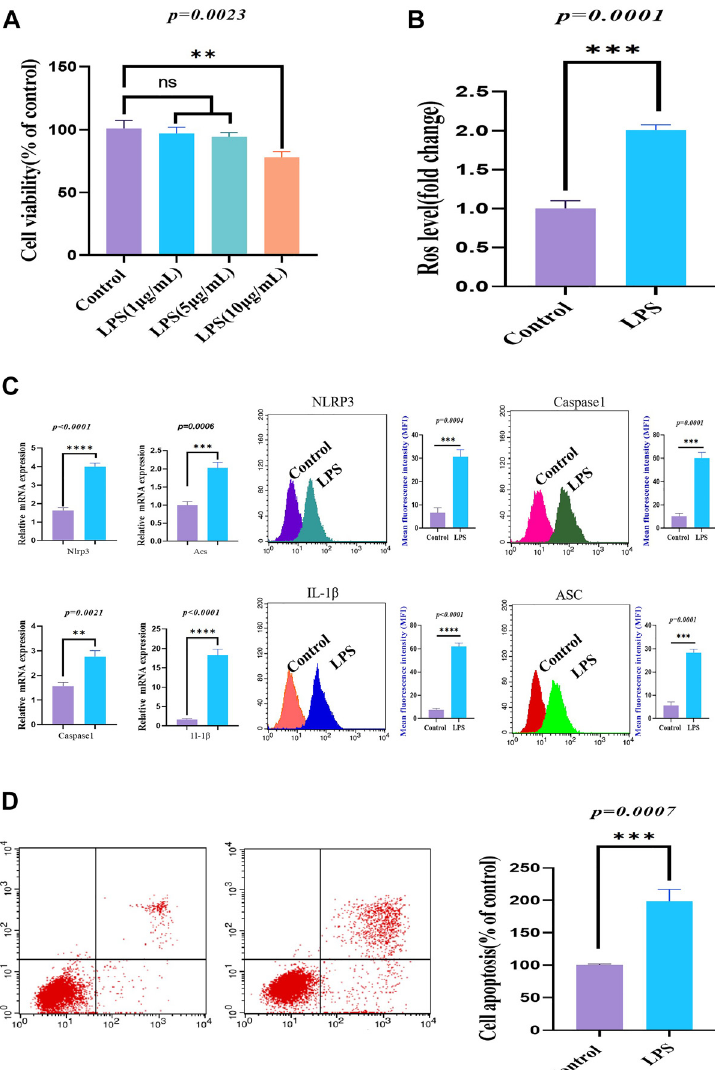
down-regulated in LPS-treated C28/I2 cells RT-PCR was performed to test the expression of MiR-22-3p in LPS-treatedC28/I2cells.Figure2showedthattheexpression level of MiR-22-3p was obviously down-regulated compared to control group.